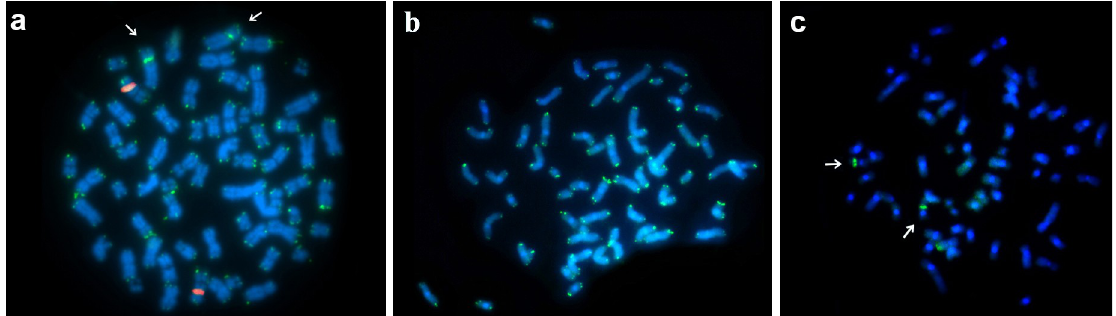
Fig 3. FISH using rDNA 45S (a, c) and telomeric (a, b) probes for L . emiliae (a) and M . stimulax (b, c). Arrows indicate the ITS for L . emiliae metaphase (a), and rDNA 45S for M . stimulax metaphase